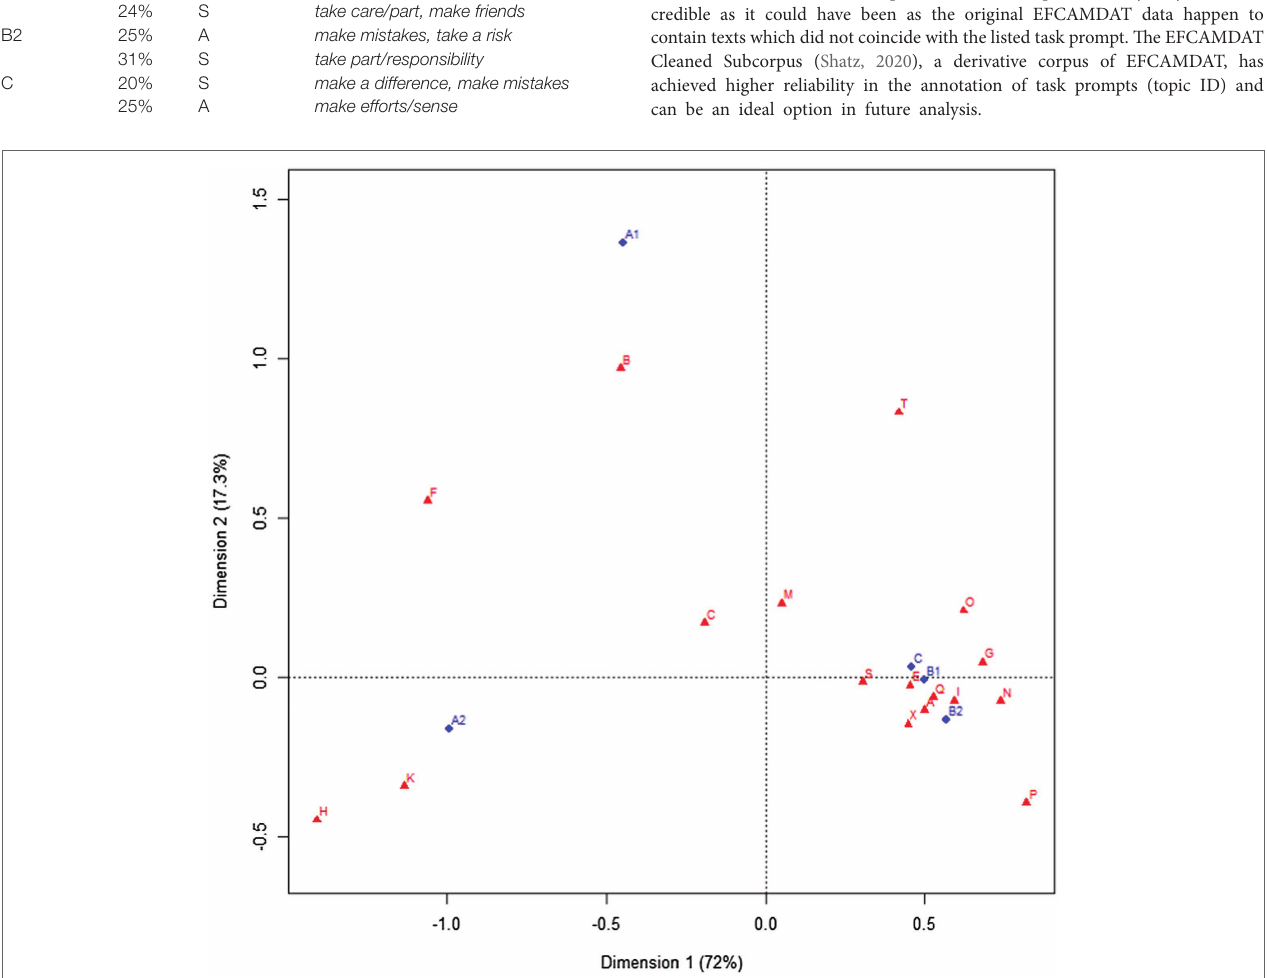
FIGURE 2 | Bi-plot of correspondence analysis: CEFR levels and semantic fields of noun elements.